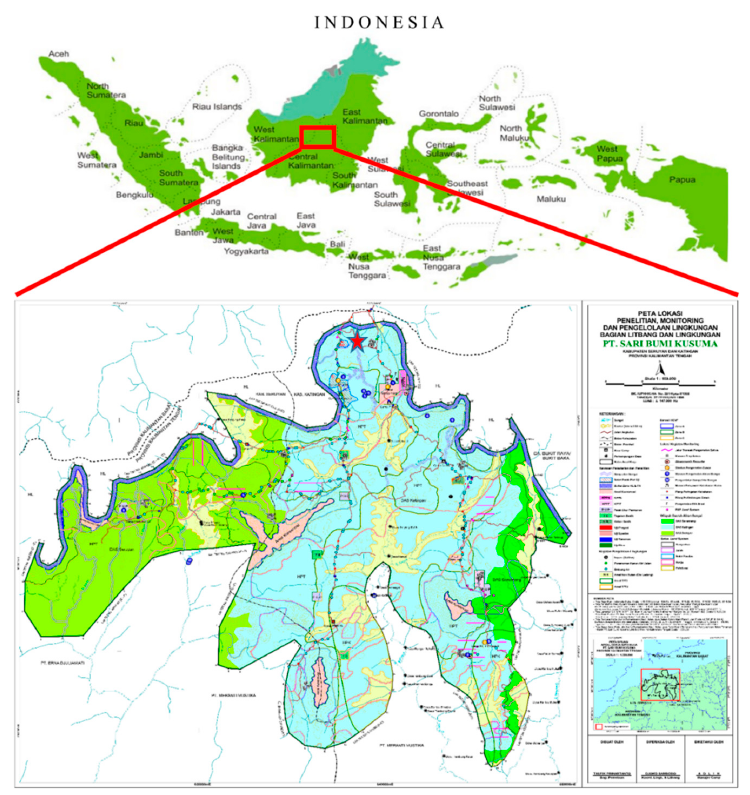
Figure 1. Shorea platyclados half-sib progeny trial research site at SBK forest concession, Central Kalimantan, Indonesia.